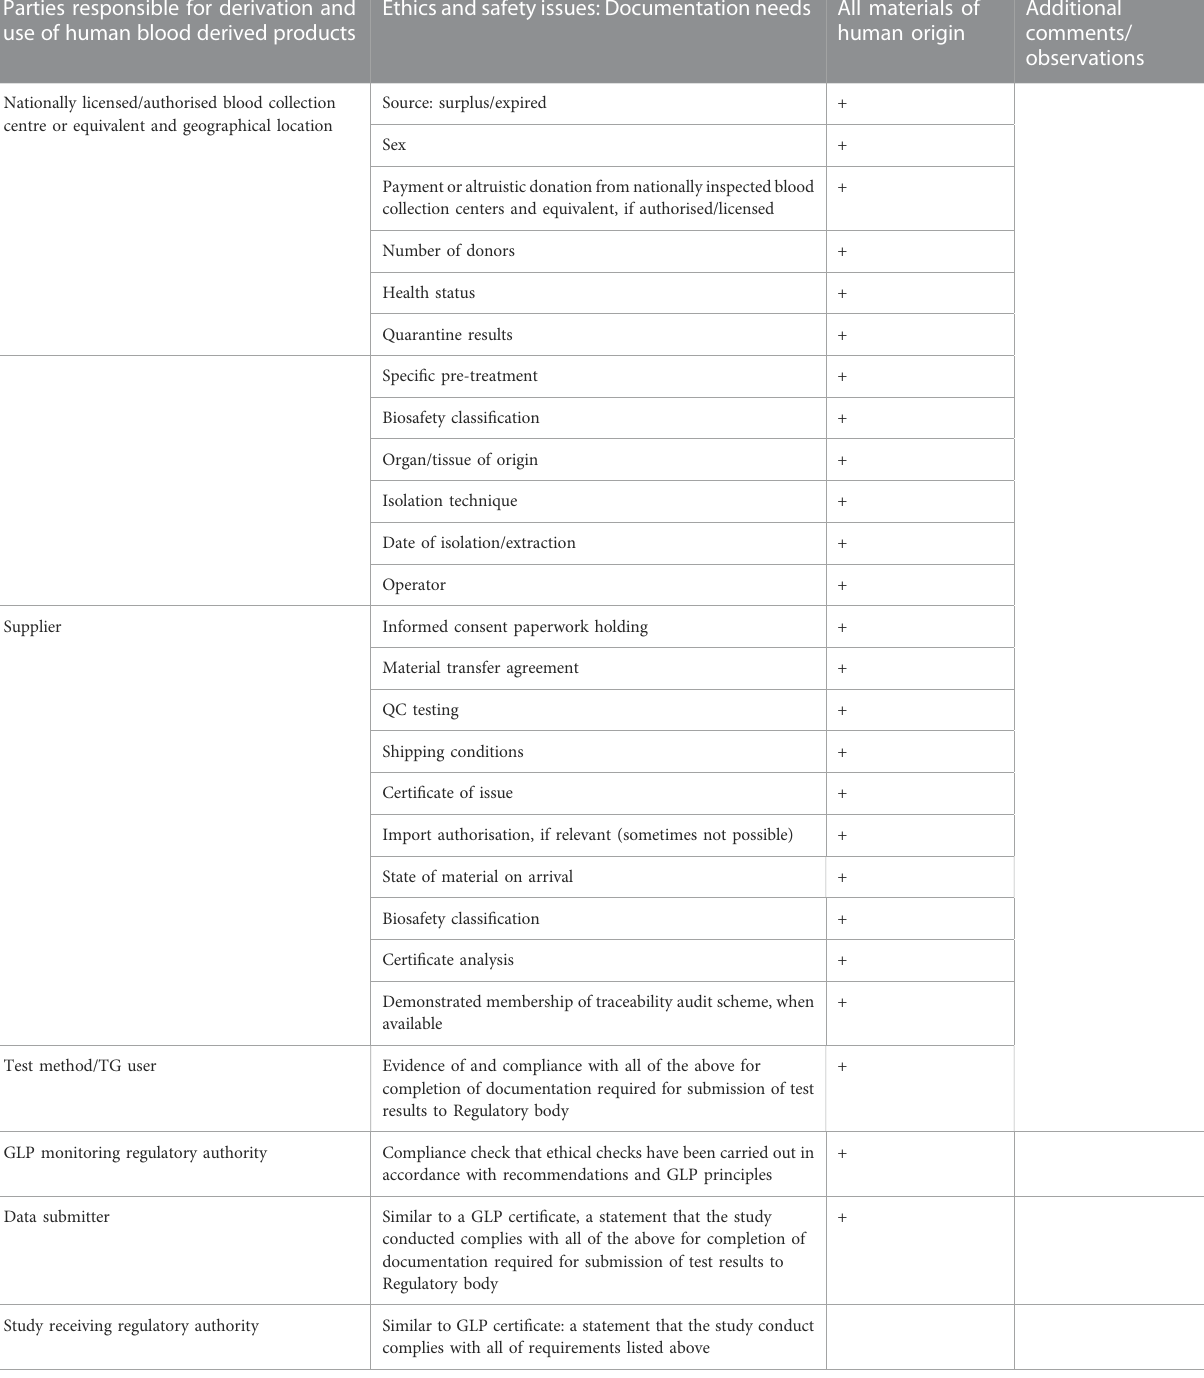
TABLE 1 Key considerations for information requirements concerning the origins of human serum and human reagents used in in vitro cell culture for OECD Test Guideline purposes to be submitted with the test results, to regulatory authorities. Parties responsible for derivation and use of human blood derived